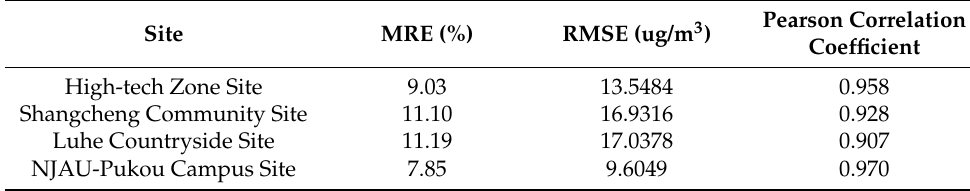
Table 5. Evaluation results of the four monitoring sites for GRU model.